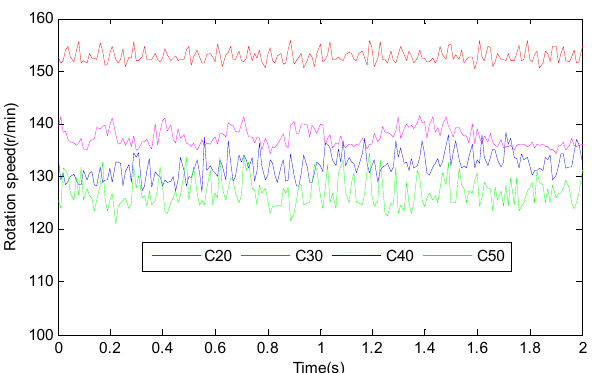
Figure 10. Torque diagram of bit drilling in the rock experiment.